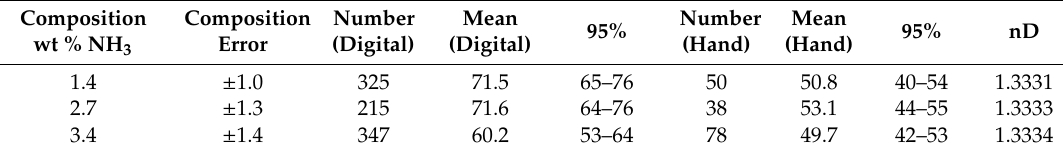
Table 2. Sample characterization for dihedral